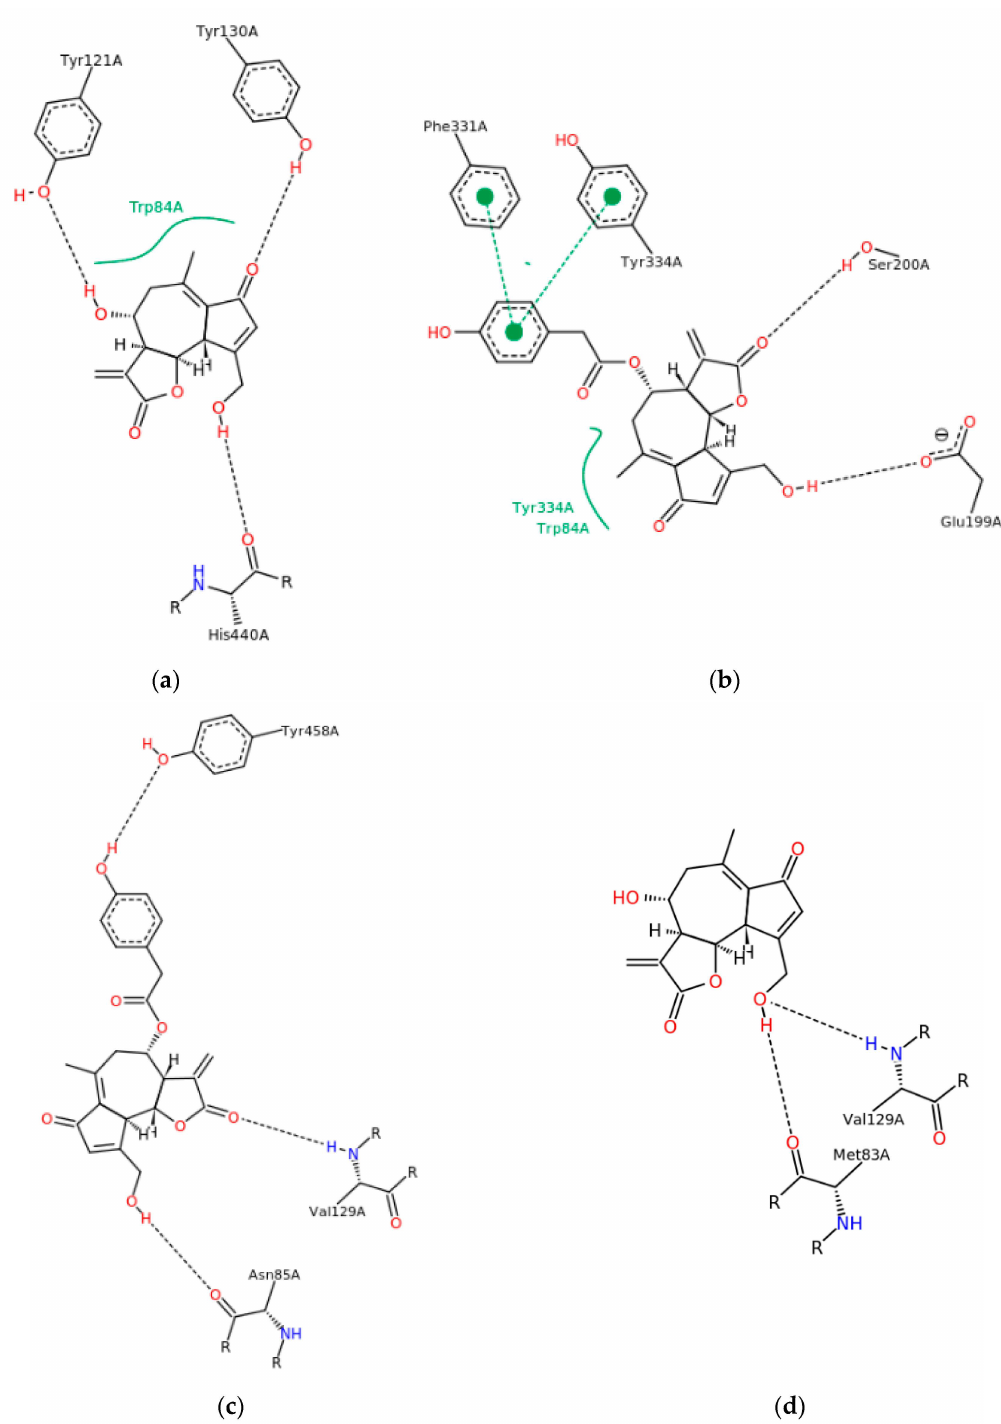
Figure 3. Depiction (in 2D) of the main interactions established between the active site of AChE and ( a ) lactucin; ( b ) lactucopicrin; ( c ) lactucopicrin in the presence of lactucin (the priority for docking was established for lactucopicrin); ( d ) lactucin in the presence of lactucopicrin (the priority for docking was established for lactucin). Continuous green lines represent hydrophobic interactions, while black dashed lines show hydrogen bonds and green dashed lines show pi-pi